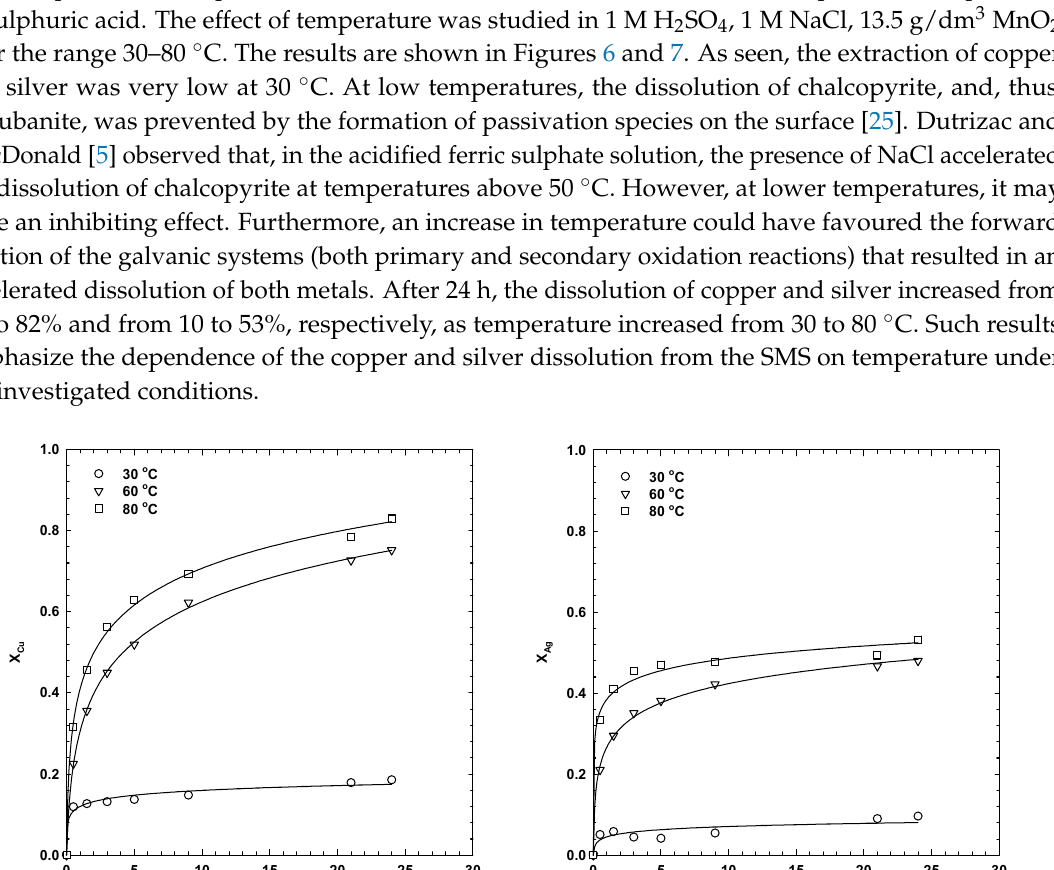
Figure 7. Influence of temperature on the ultimate dissolution of copper ( a ) and silver ( b ) after 24 h (1 M H 2 SO 4 , 1 M NaCl, 13.5 g/dm 3 MnO 2 , 30 g/dm 3 SMS, 300 rpm).